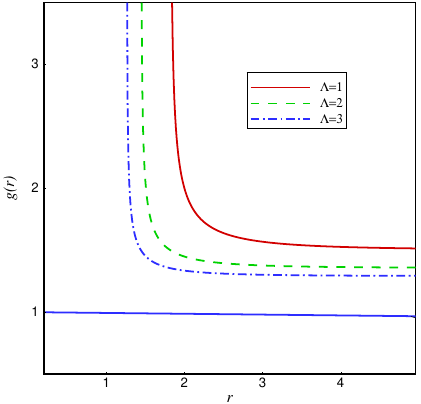
Figure 3 . The behavior of g ( r ) for rotating black string. Here we have taken b 0 = 1 = 2 and m =